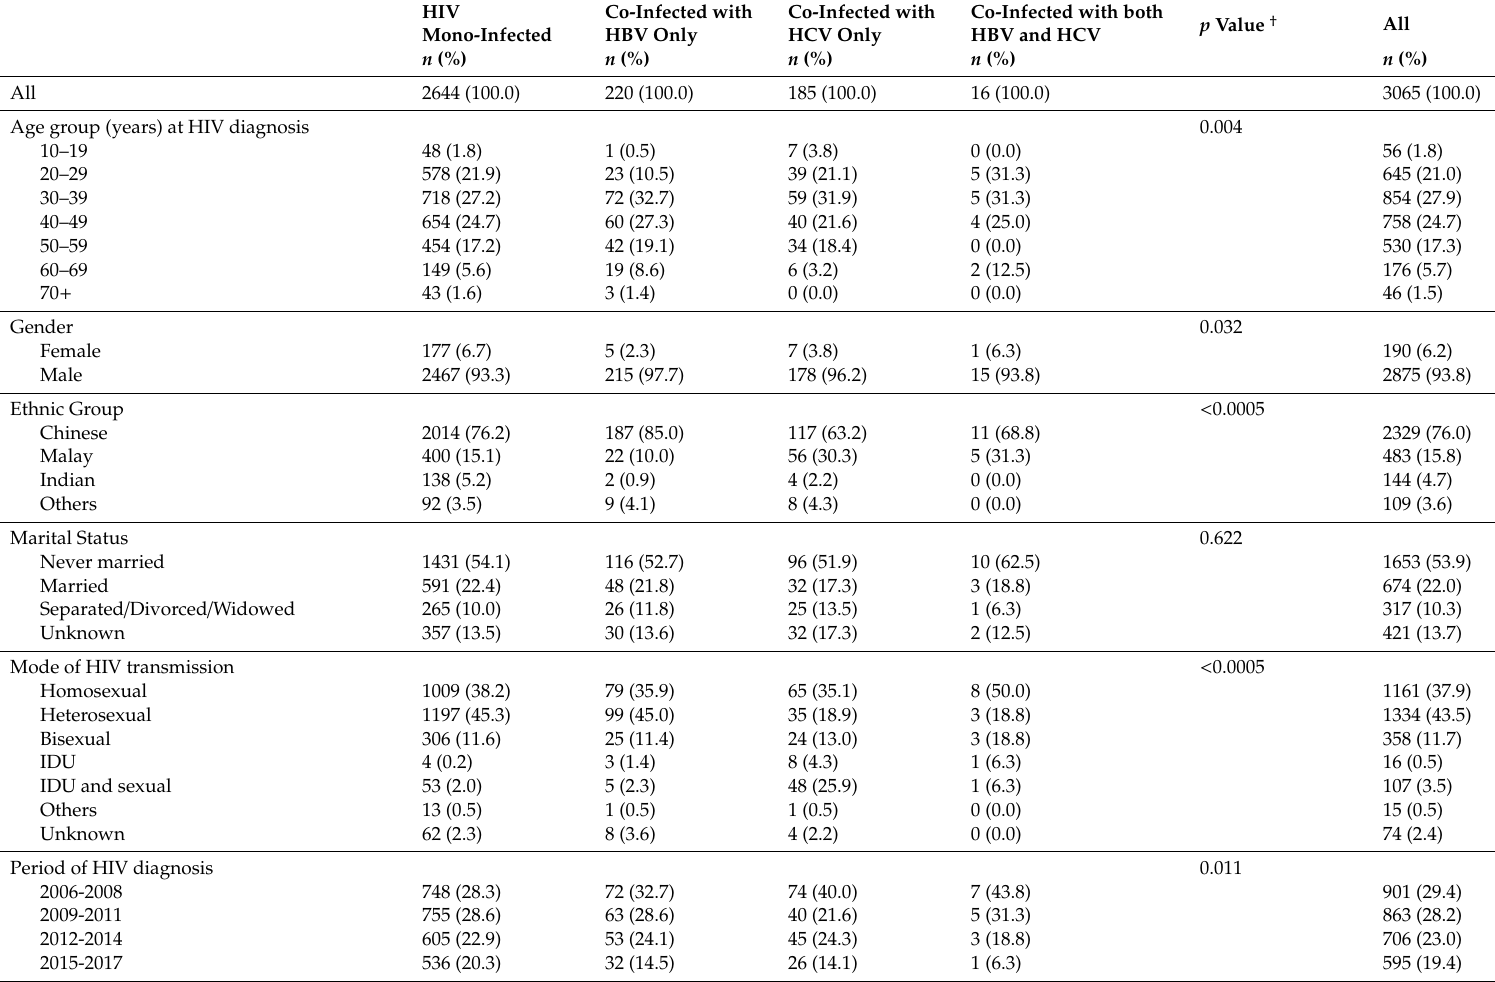
Table 1. Epidemiological characteristics of HIV-infected patients with mono-infection and HBV and HCV co-infections who attended the national referral centre for HIV in Singapore,